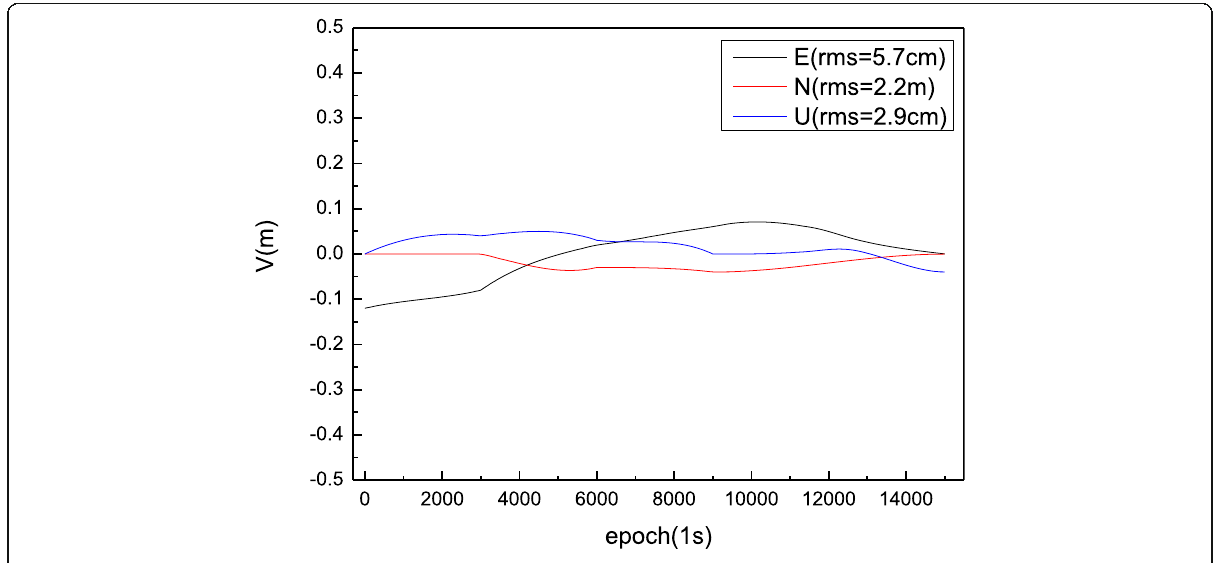
Fig. 6 Dynamic positioning deviation and RMS value of case